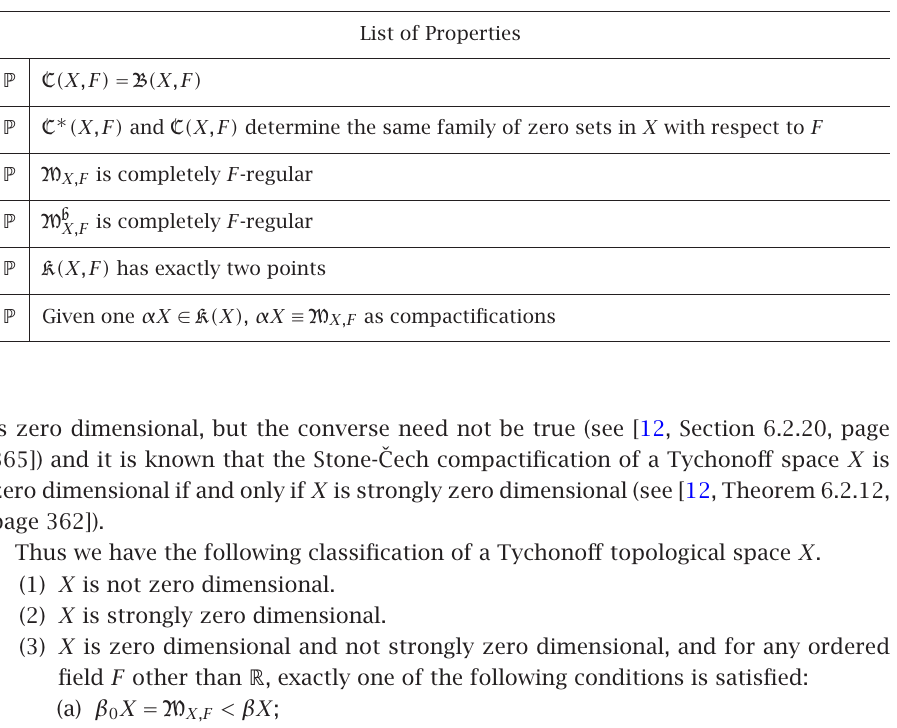
Table 4.1 . List of properties of the pair (X,F)